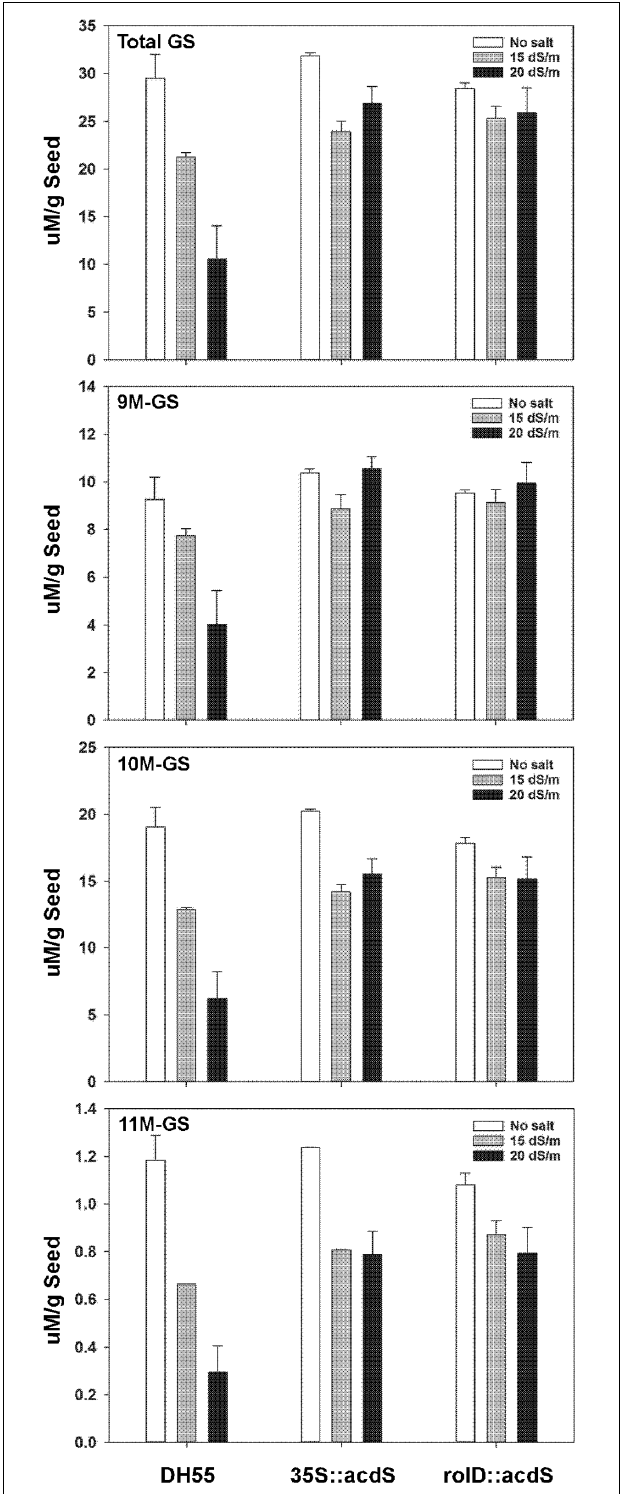
FIGURE 12 | The effect of acdS expression on seed glucosinolate levels in camelina plants grown in the absence of, or presence of, salt (15 and 20 dSm − 1 ). Lines tested include wild-type C. sativa DH55 and